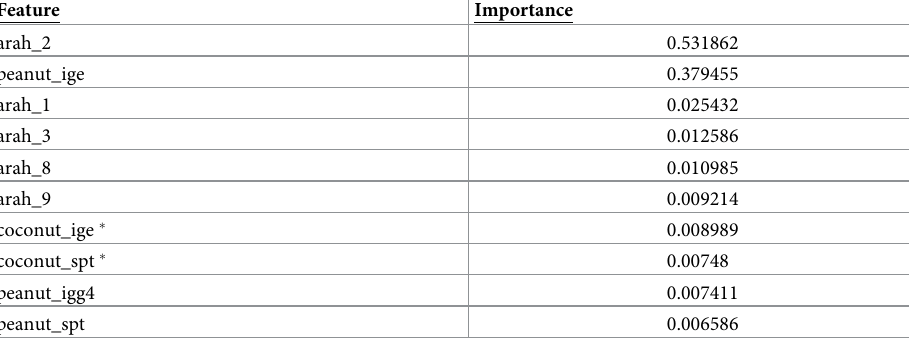
� Indicates features not present on the a priori set. Importance values are normalized and meant to indicate a relative importance of the features rather than the weights of the variables.